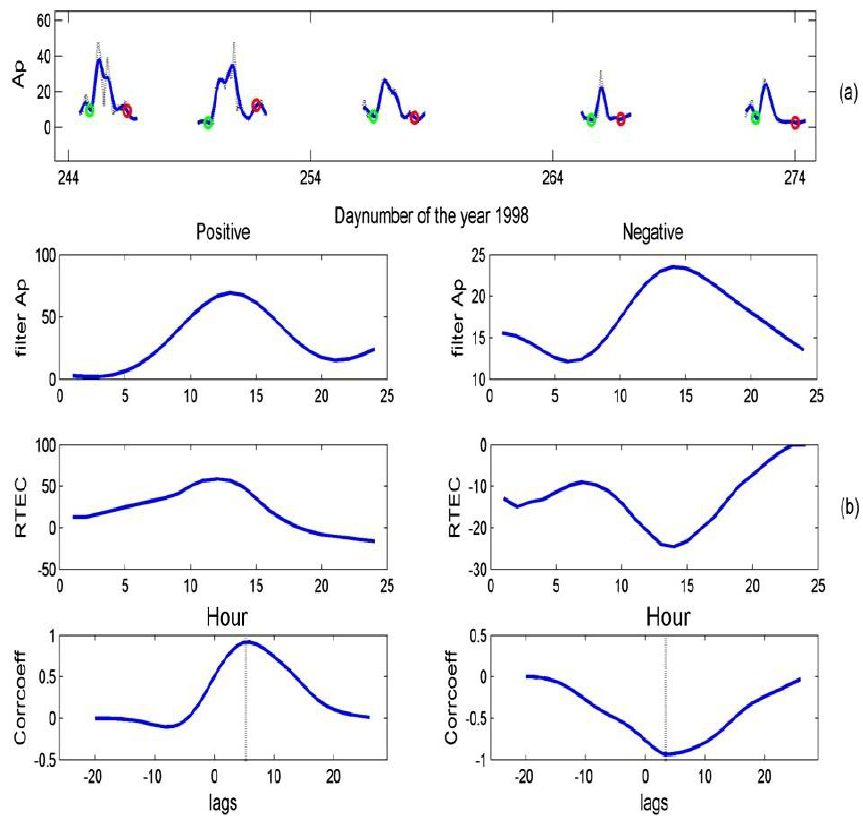
Fig.1. (a) Geomagnetic activity during the 244 th -274 th days in the year 1998. Fig. 1. (a) Geomagnetic activity during the 244th–274th days in the year 1998. (b) Example of a period of geomagnetic disturbance and (b) Example of a period of geomagnetic disturbance and associated positive and associated positive and negative ionosphere responses RTEC, as well as their cross-related negative ionosphere responses RTEC, as well as their cross-related functions.